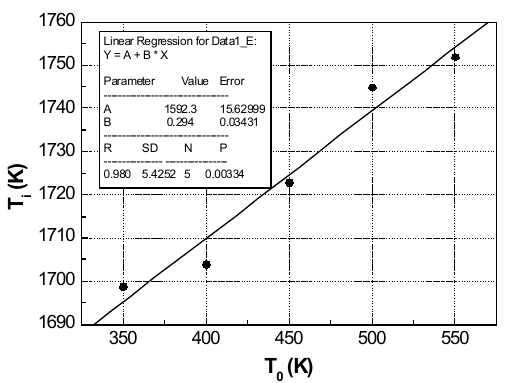
H -air mixture, at 2 6